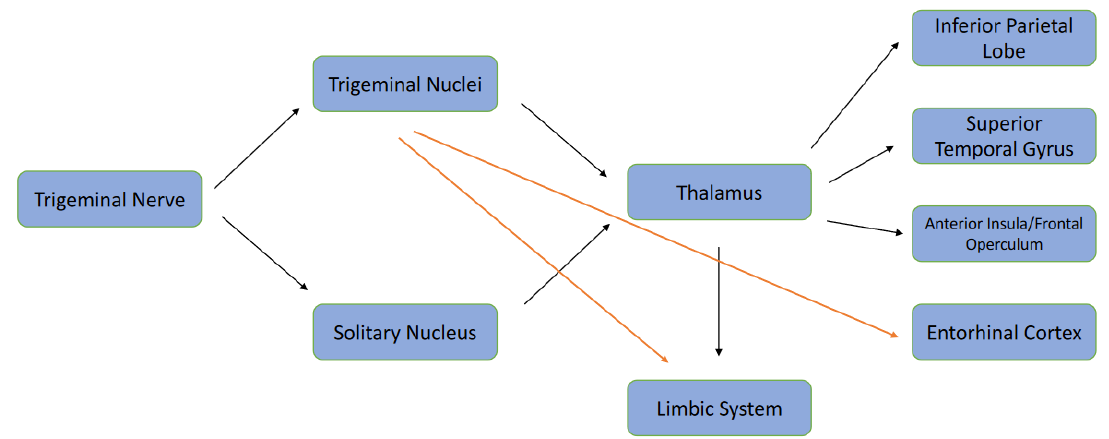
Figure 1. Trigeminal Neuro-anatomical Connections. Black Arrows: Established Pathways. Red Arrows: Hypothetical Pathways.